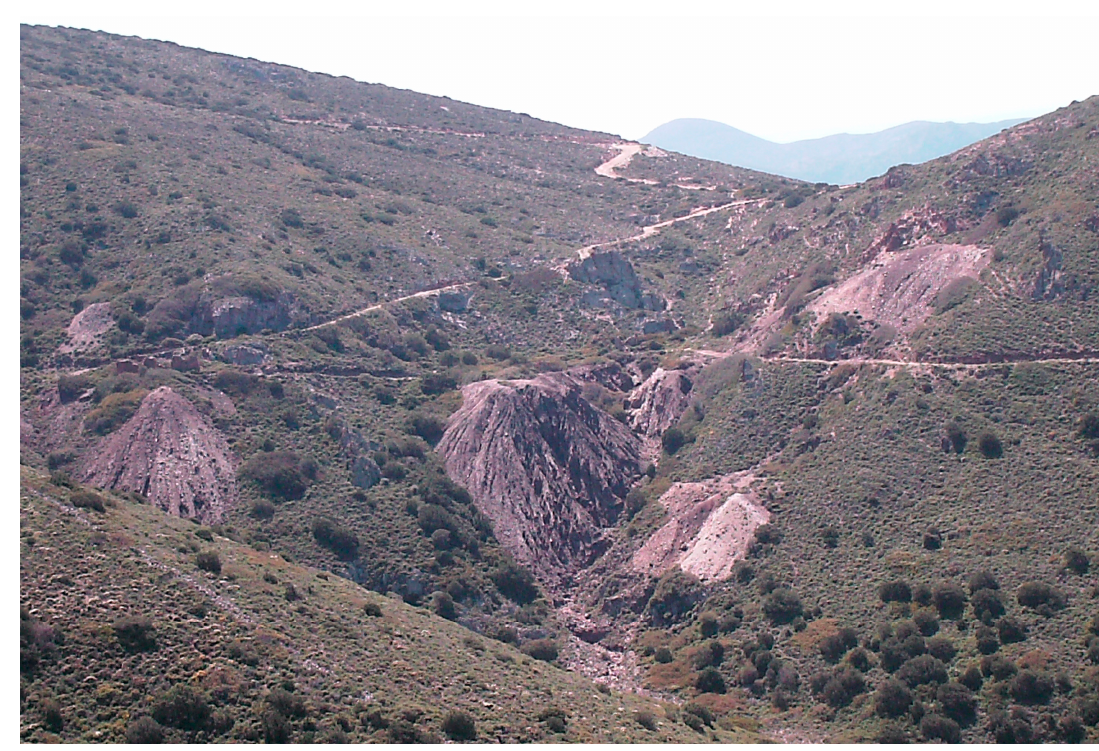
Figure 5. The talus cones of area 5 as mapped in the field.